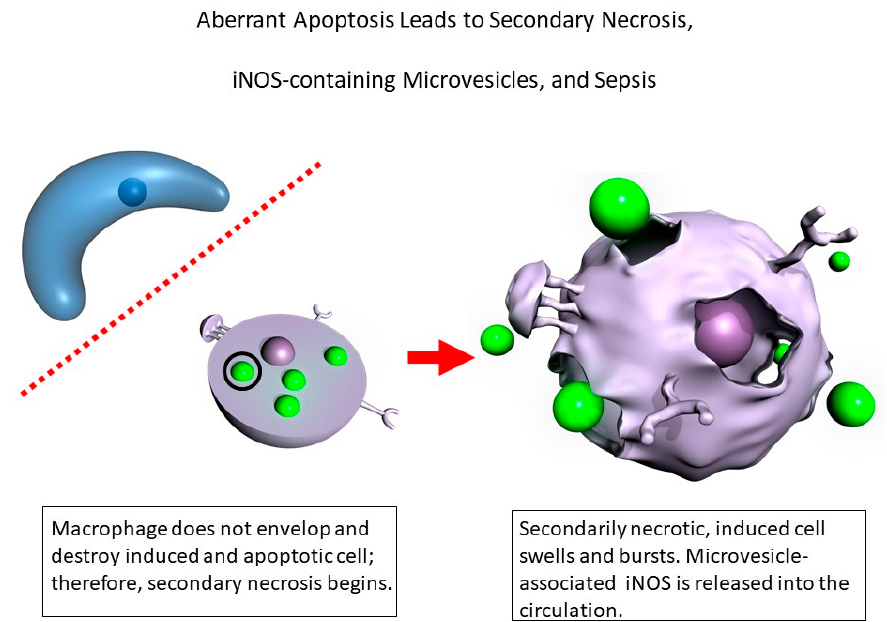
Figure 3. Published data by our team [6–8,33] demonstrate that what triggers sepsis is aberrant apoptosis that leads to secondary necrosis of cells induced to produce iNOS, to the release into the circulatory system of microvesicle-associated iNOS, and ultimately to the life-threatening sepsis cascade. This is a new pathophysiological pathway that was recently discovered and confirmed for the sepsis pathology. The left-hand side of the illustration depicts a cell that has been induced by the inflammatory cytokine storm to make iNOS. The red dashed line indicates that macrophages (Mø) do not recognize this cell as apoptotic. Thus, this induced apoptotic cell is not properly scavenged by a macrophage and instead undergoes secondary necrosis, which is depicted in the right-hand side of this illustration. The secondarily necrotic, induced cells swell, burst, and release their cellular contents into the circulatory system, including iNOS-containing microvesicles (depicted as extracellular green balls).